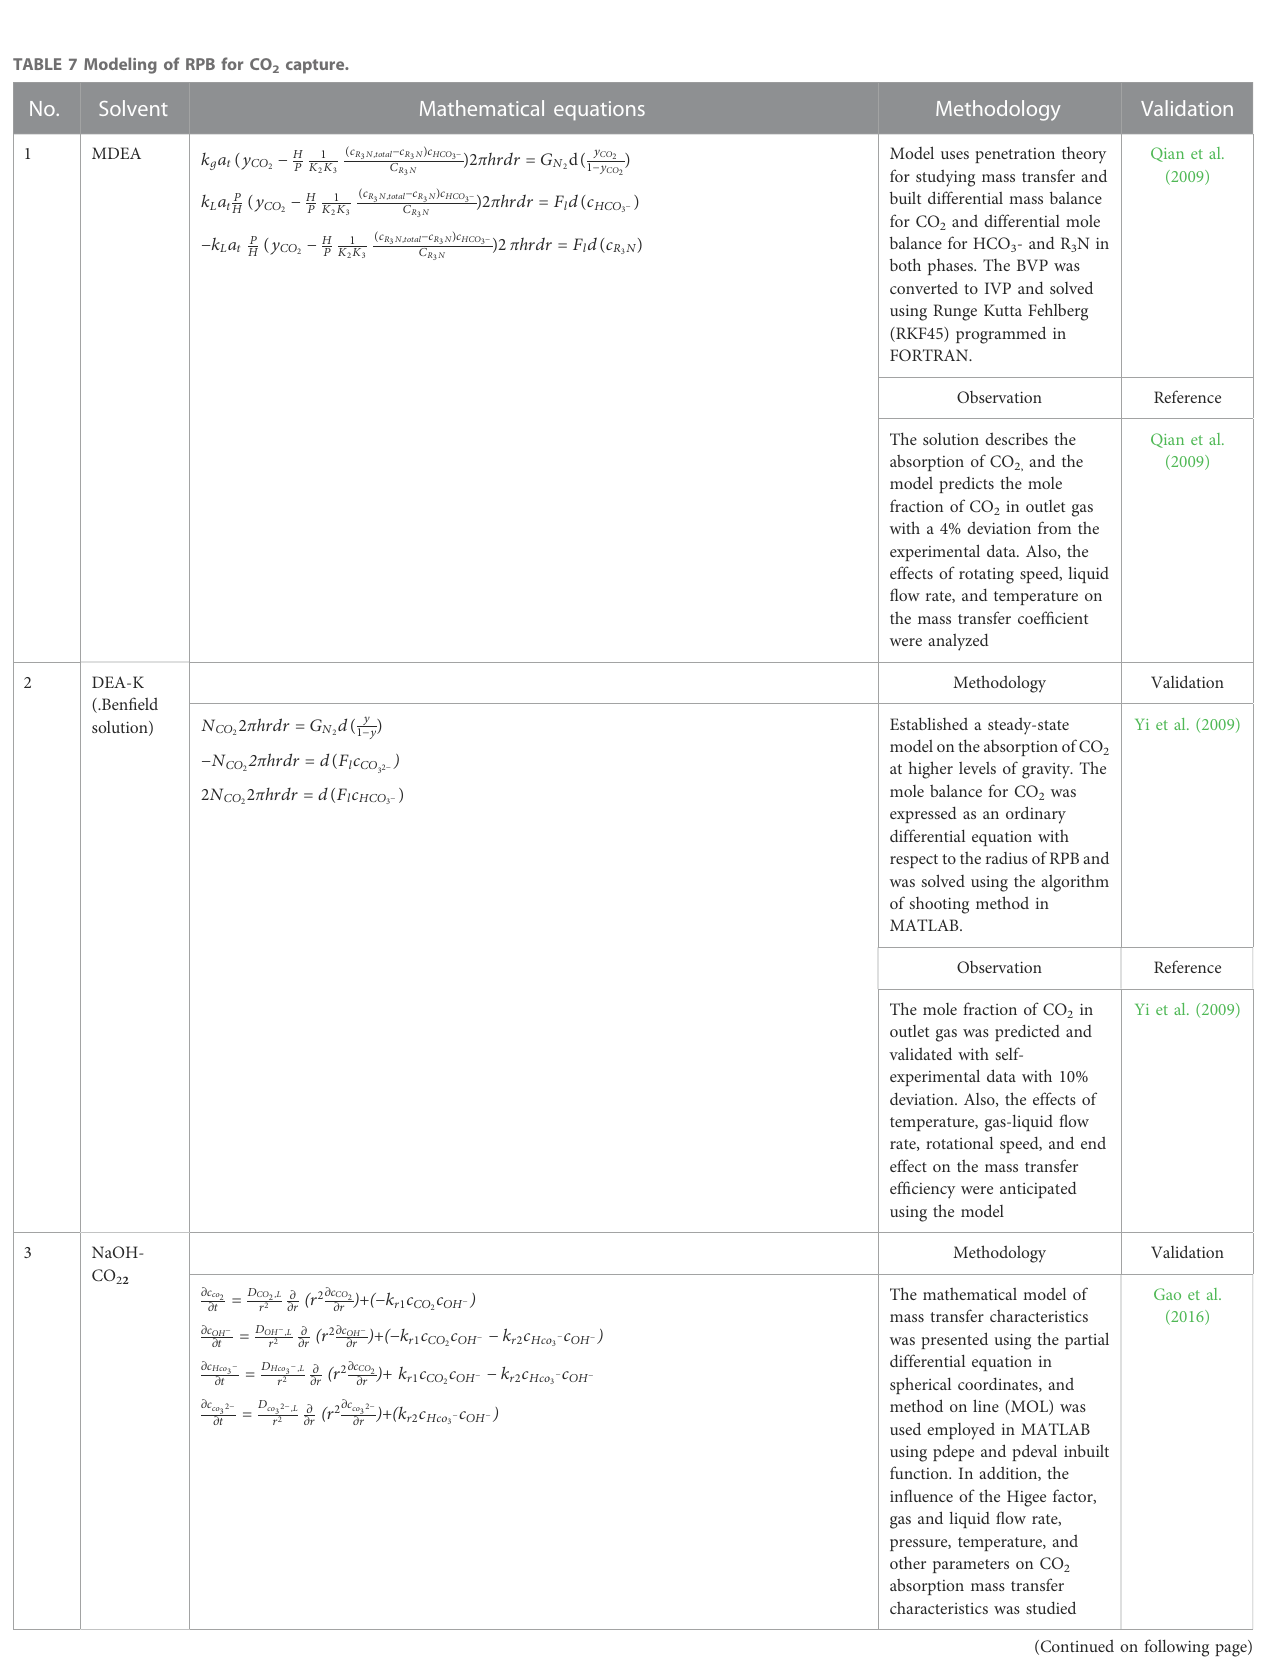
TABLE 7 Modeling of RPB for CO 2 capture. No.